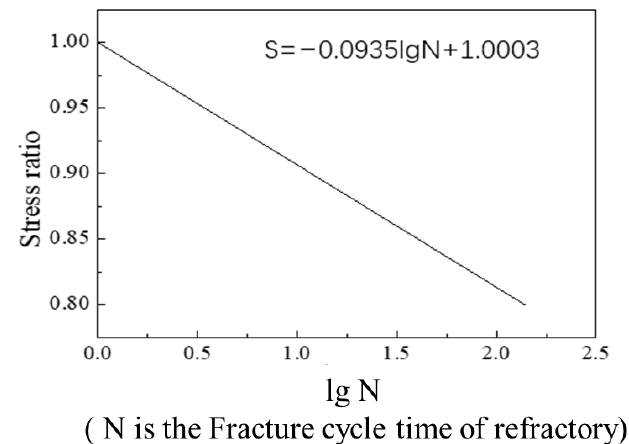
Figure 14. Low cycle fatigue characteristic curve of the working layer [23].